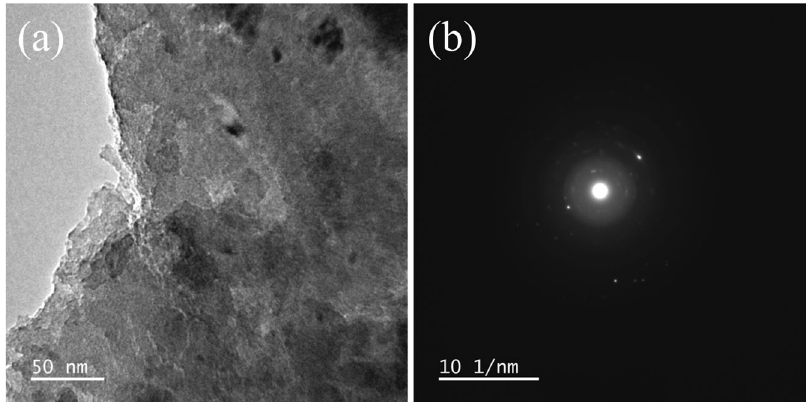
Fig. 13 TEM images and SAED pattern of amorphous region. a Bright- fi eld TEM image, b SAED pattern, obtained from amorphous region of the zircon immersed in 0.1 M NaOH (aq). The scale bar on the left image is 50 nm, the right is 10 nm − 1